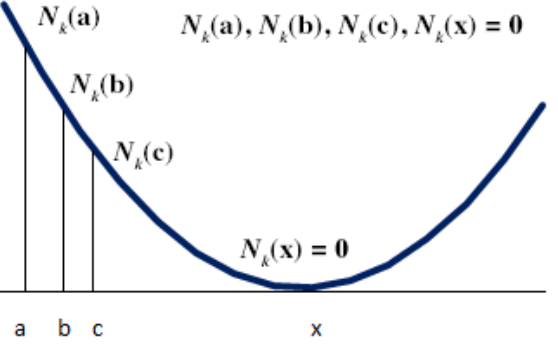
Fig. 5. SLESR and ESR on the straight line in the vicinity of the SLE solution.